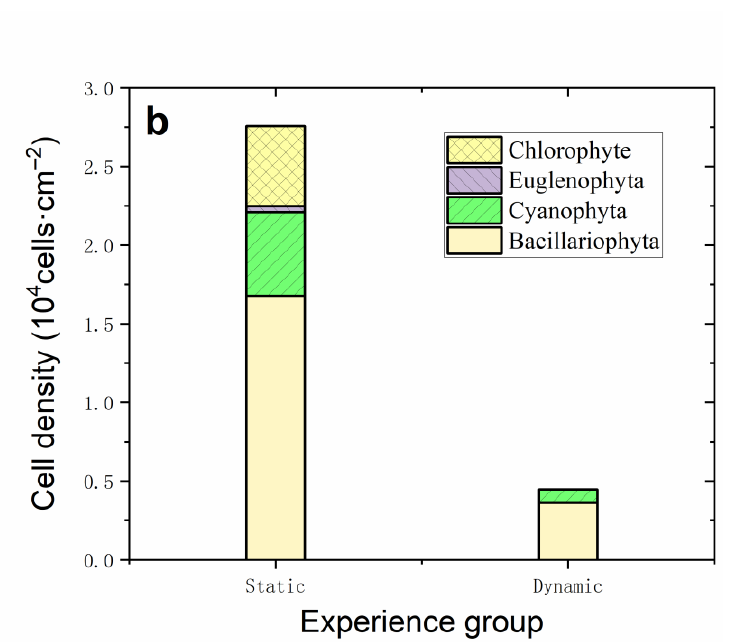
Figure 6. Effects of water flow on ( a ) algae species and ( b ) algae cell density on the epiphytic biofilm of V. natans after 60-day cultivation.